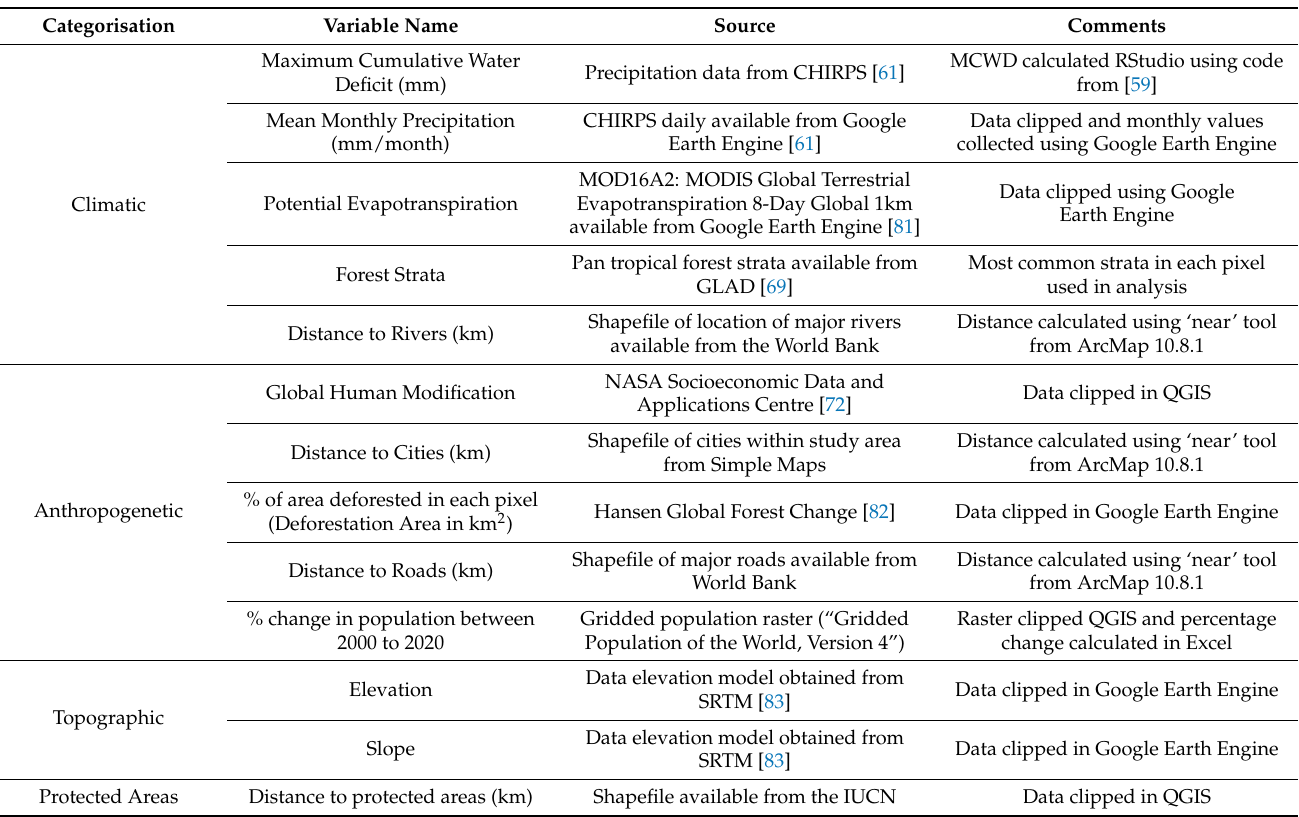
Table 1. Summary information for the different variables used to identify the drivers of fire dynamics, their source and brief comment on their data handling and processing [69]. All the response variables were considered at the spatial resolution of 1 km. Most of the response variables were available at this spatial resolution. The response variable raster layers with finer spatial resolution was aggregated by mean, and those with coarser spatial resolution were resampled using bilinear interpolation to the target resolution of 1 km × 1 km